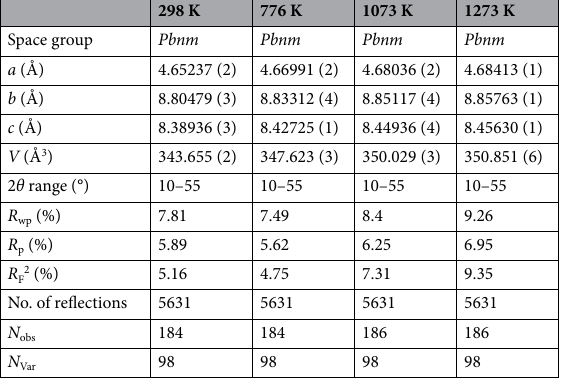
Table 1. Refinement details of the synchrotron data collection and unit cell parameters of topaz at 298, 776, 1073 and 1273 K. R